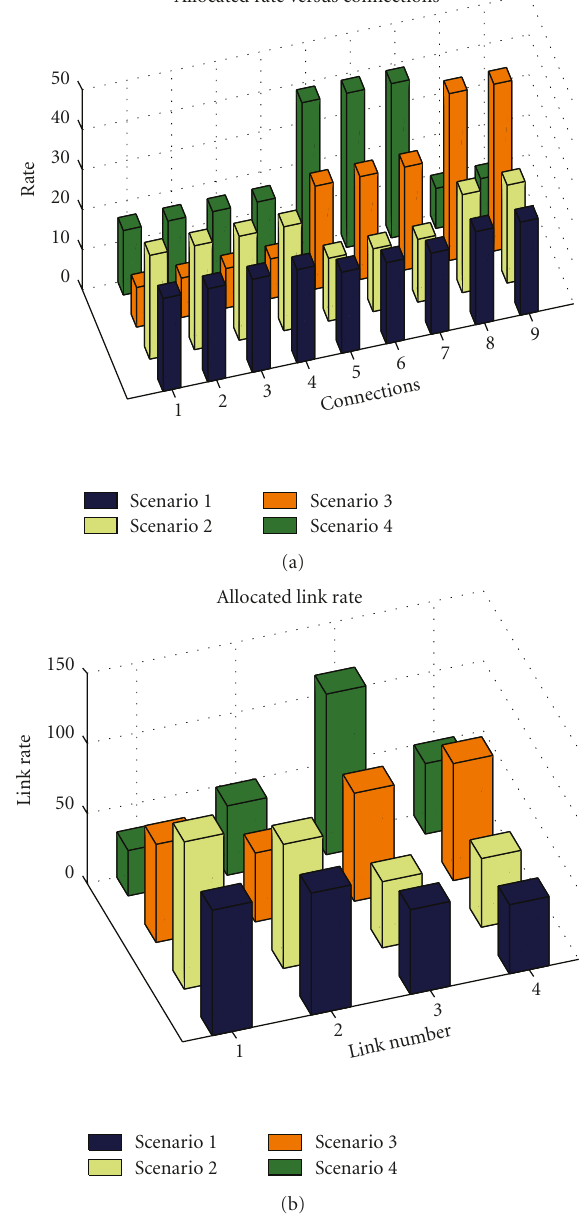
Figure 7: Three di ff erent allocation examples.